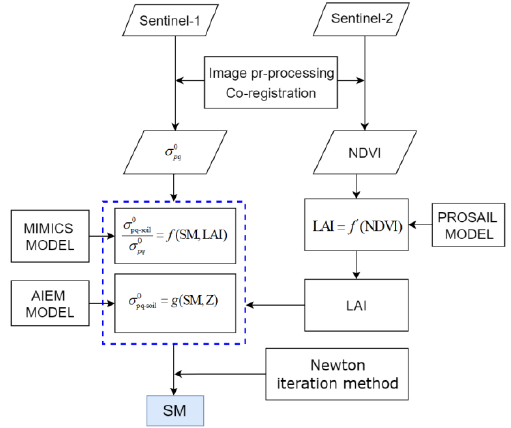
Figure 2. Flowchart of the SM retrieval process.